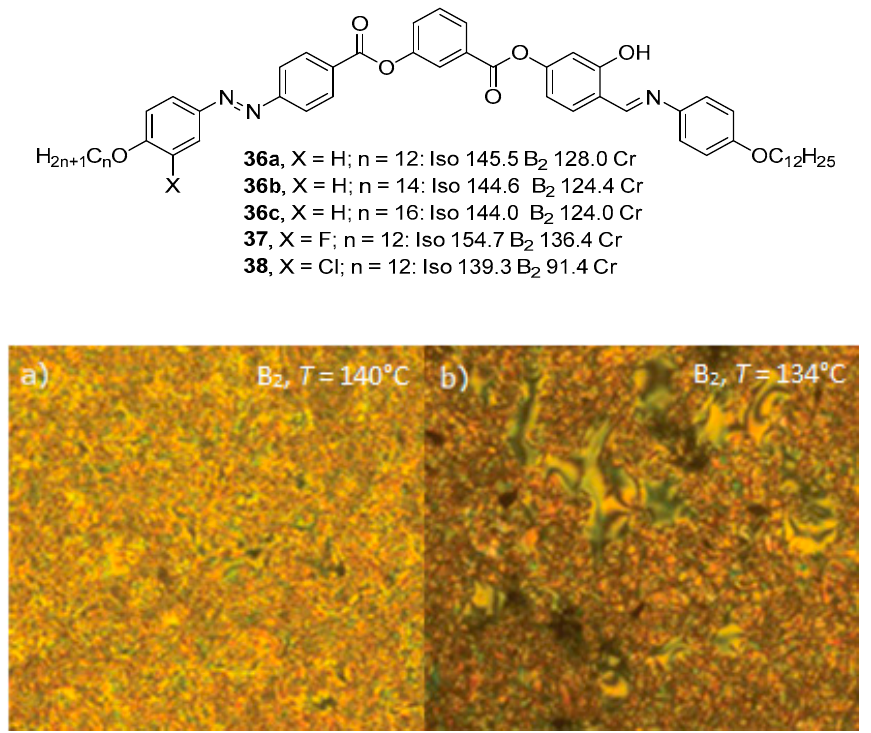
Figure 8. The B 2 mesophase observed under the POM for compound ( a ) 36c at T = 140 °C and ( b ) 36b at T = 134 °C [115].